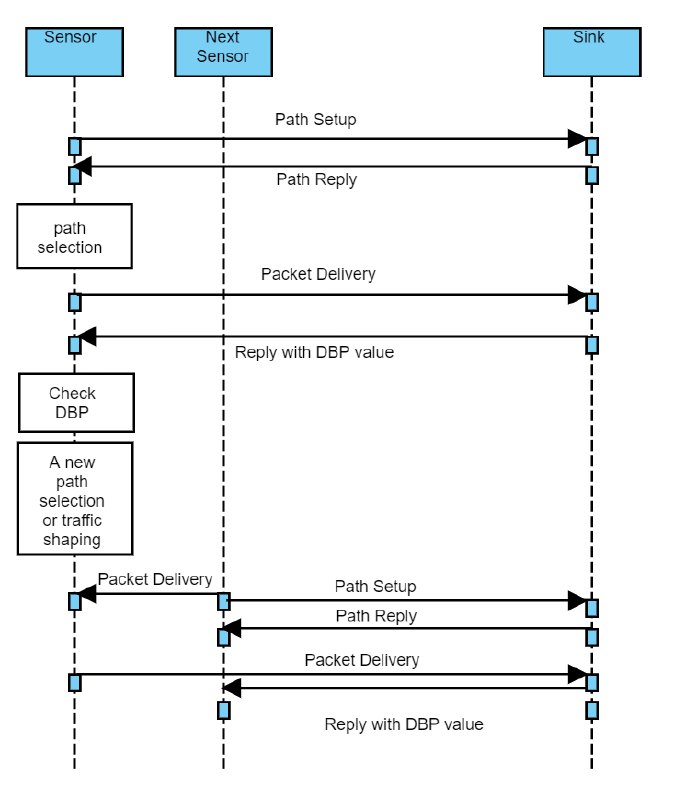
Figure 2. Overview of the proposed real-time